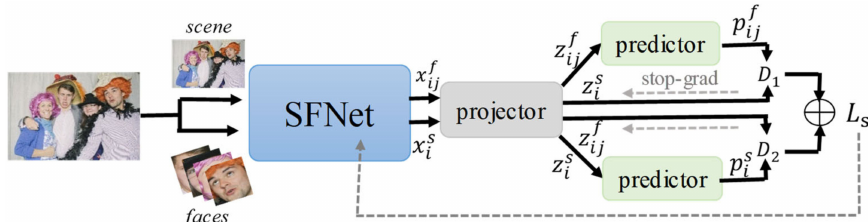
Figure 3. Pretraining flow of the